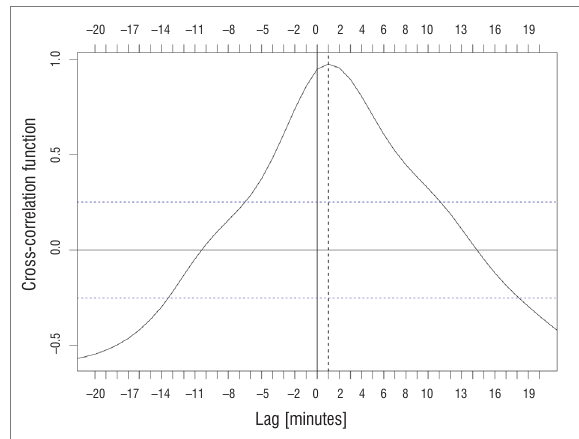
Figure 8: Cross-correlation between the 0.1–0.8 nm X-ray flux and the GQD phase